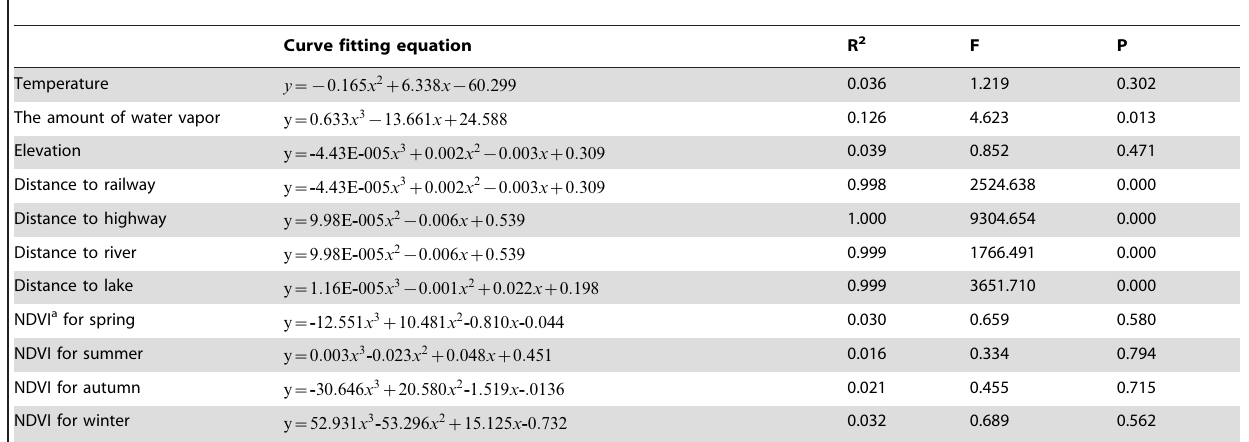
Table 3. The results of single factor analysis between the incidence of HFRS and potential influencing factors in Jiangsu from 2001 to